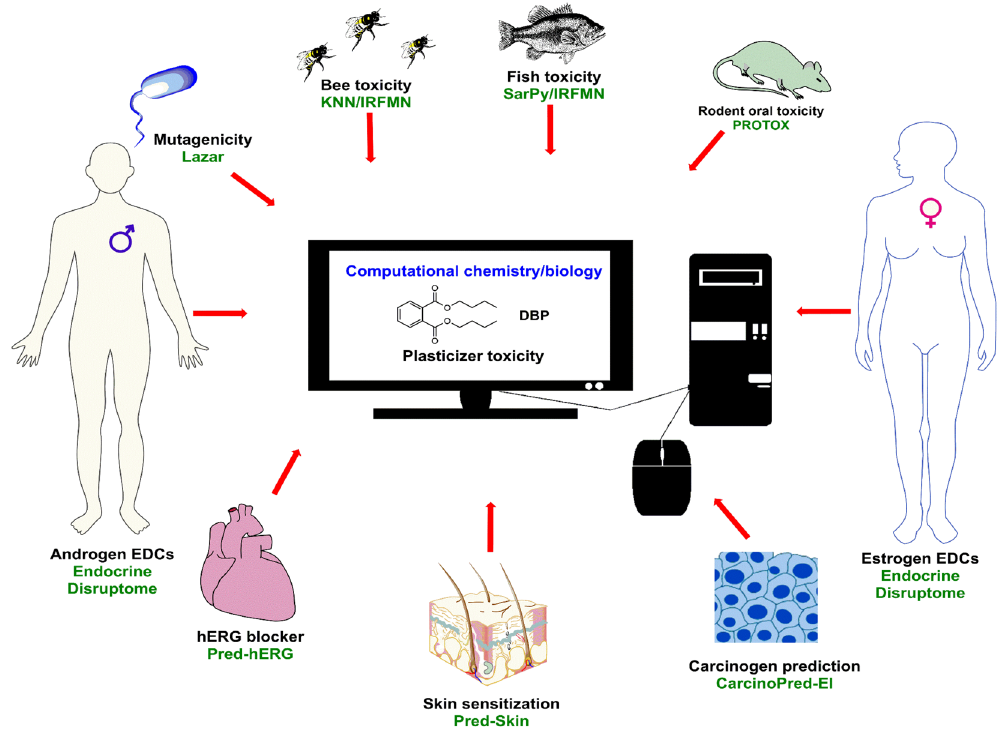
Figure 1. Pictorial representation of in silico analysis of various predictive toxicity analysis (ChemBioDraw Ultra 14—https:// scist ore. cambr idges oft. com/ chemb